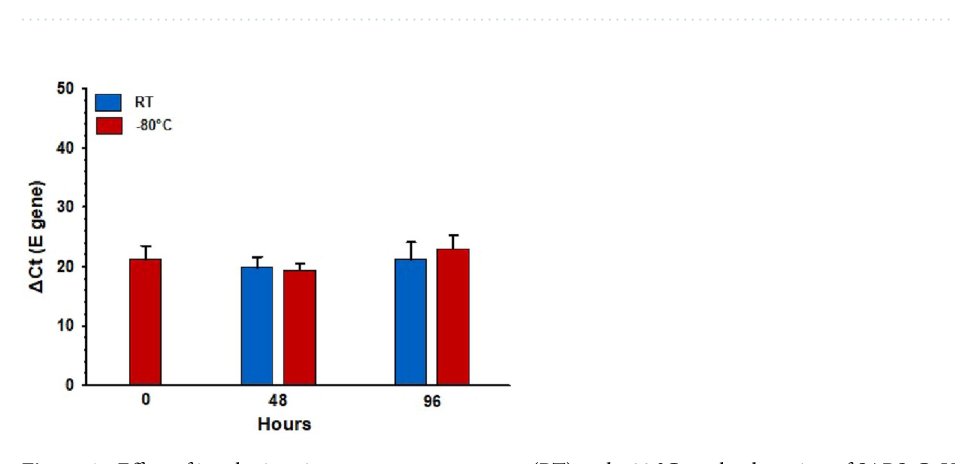
Figure 3. Representative microscopic images of KN95 and N95-3 M masks showing fabrics after 0, 0.5, 5 and 15 kGy low dose rate gamma irradiation (0.5088 kGy/hour). Arrows indicate physical changes (e.g. holes) within masks’ fabrics resulting from alteration in polymer homogeneity following irradiation. Photomicrographs are at 5 × magnification where scale bars show 1 mm.